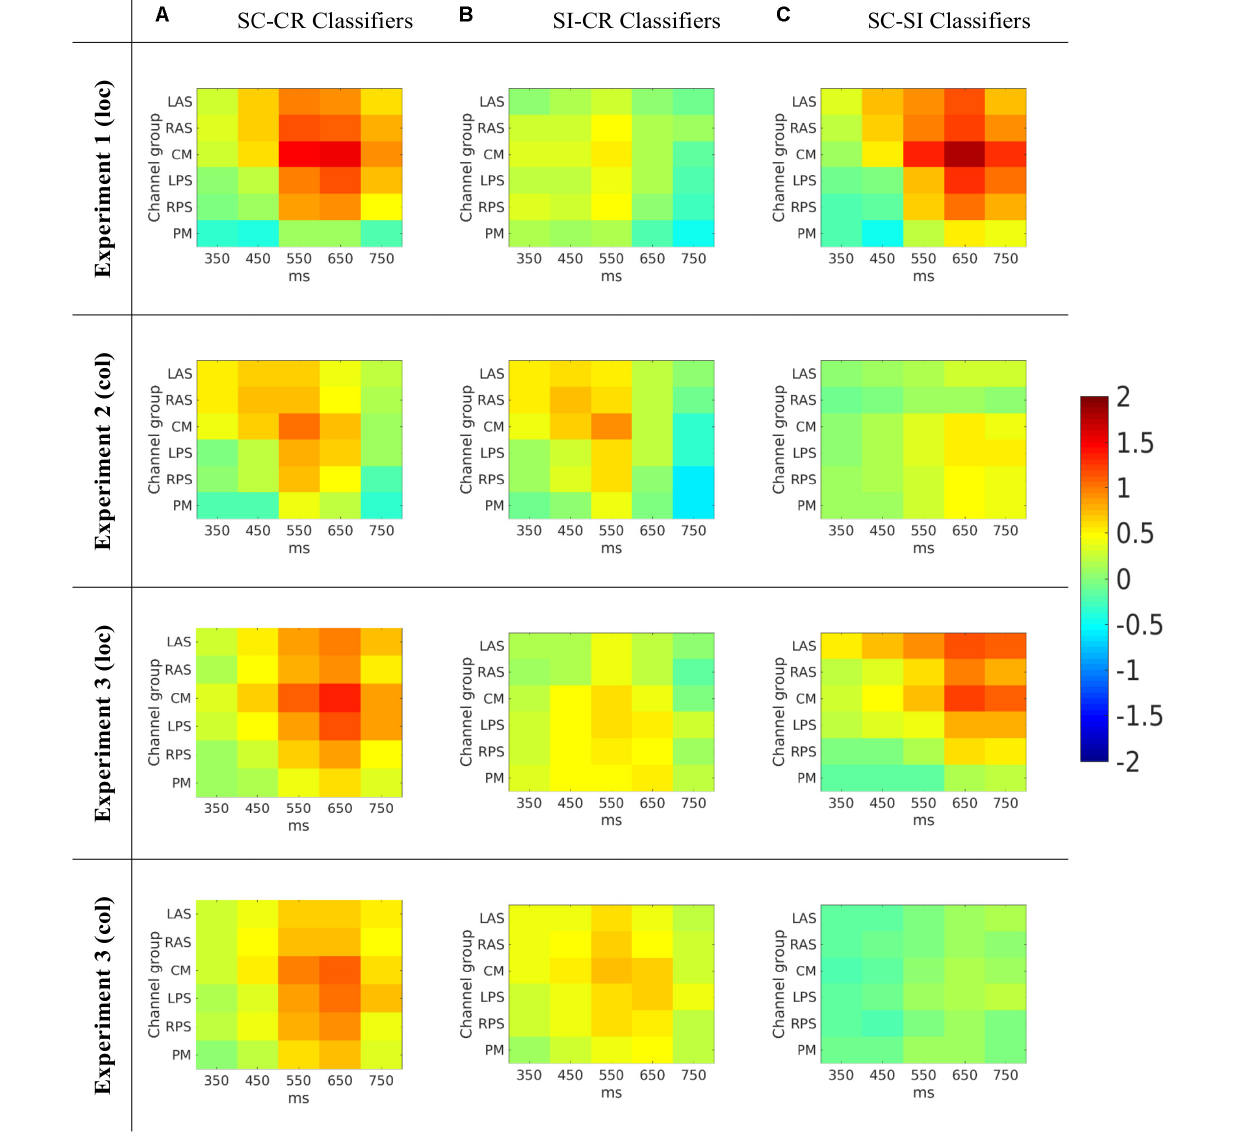
FIGURE 7 | (A) The average activation patterns from the SC-CR classifiers averaged across all available subjects. (B) The average activation patterns from the SI-CR classifier averaged across all available subjects. (C) The average activation patterns from the SC-SI classifiers averaged across all available subjects. Note that the numbers on the x -axes represent the mid-point of the 100 ms window used to compute the